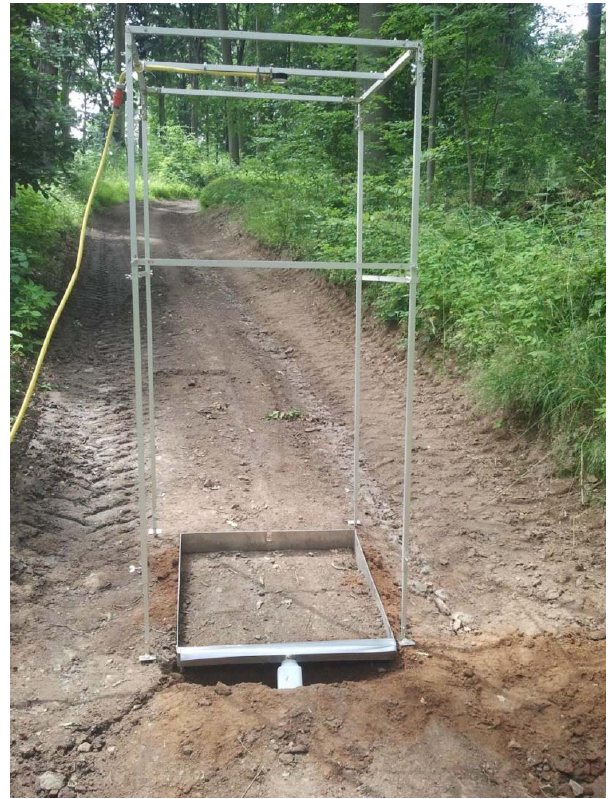
Figure 2. Rainfall simulator setup on a forest road, windshield removed for a better visibility.